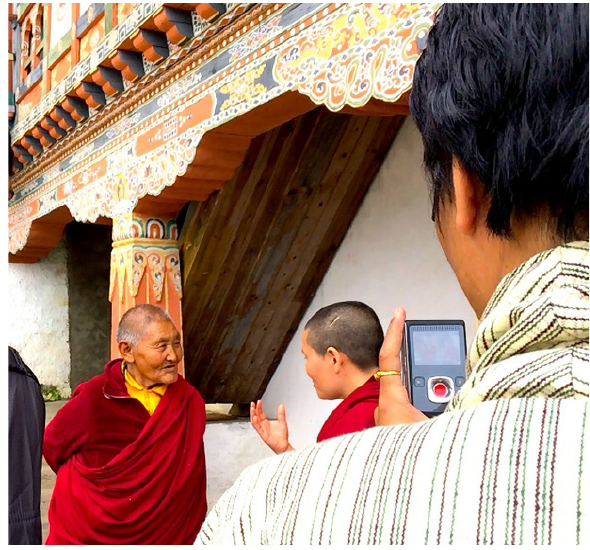
Figure 3. Video interview of monastery